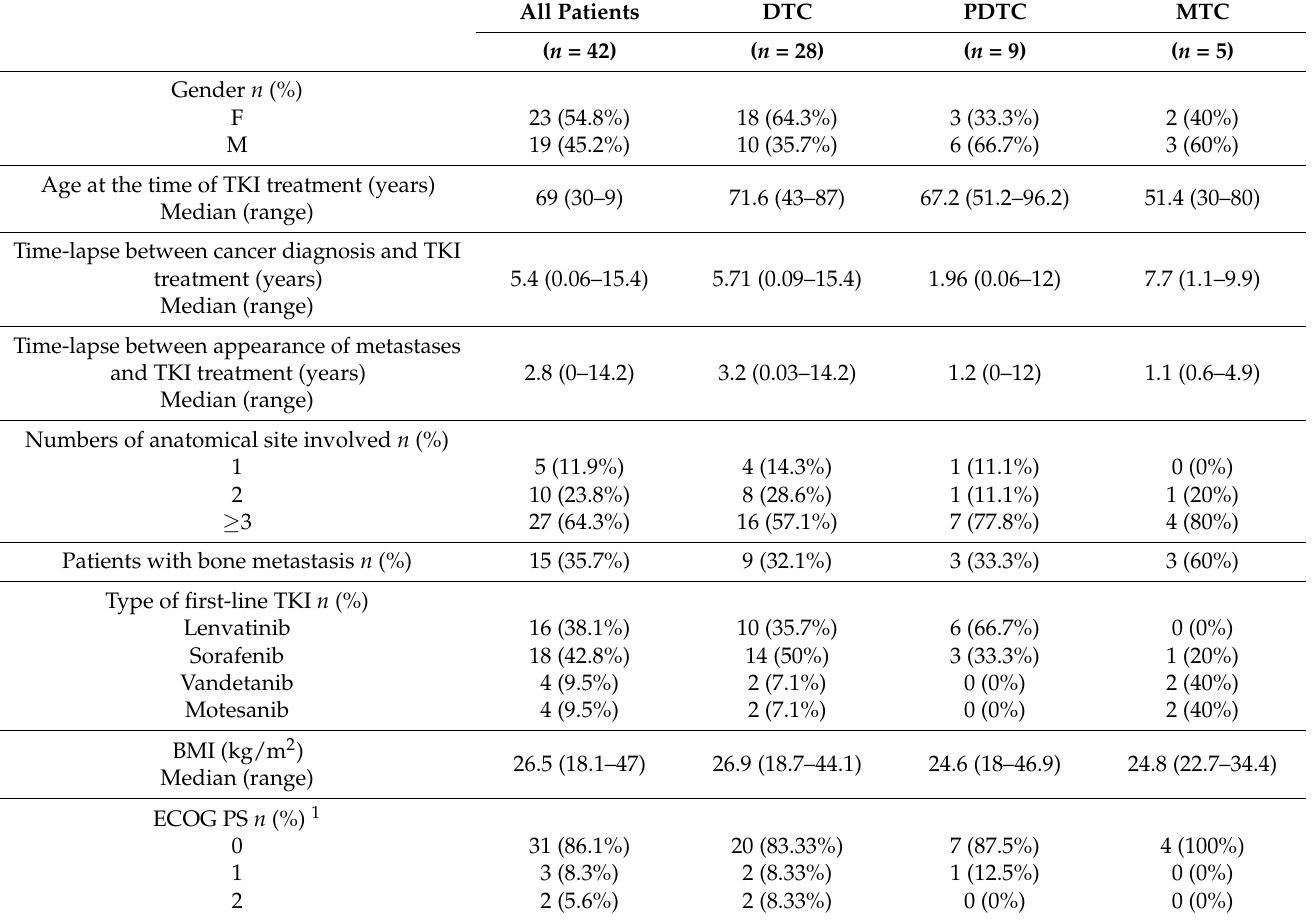
Table 1. Baseline clinical-pathological features in the whole population and according to histological